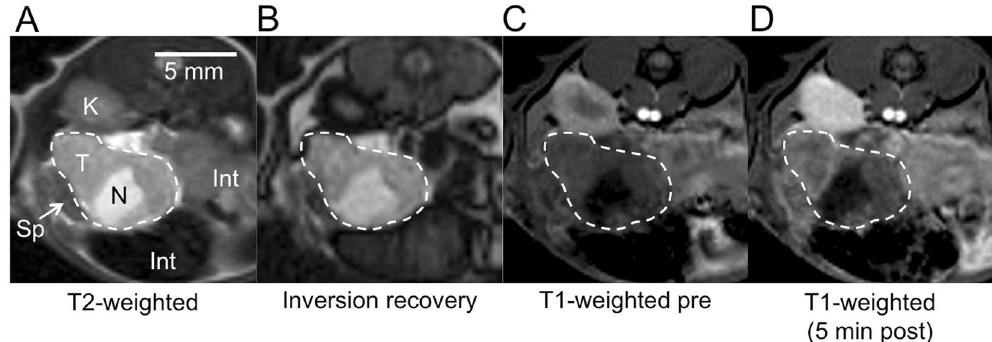
Figure 2. Axial MR images used to identify and characterize PDAC tumours in the mouse abdomen. Tumour is outlined. (A ) T2-weighted image. T = tumour, N = necrosis, Sp = spleen, K = kidney, Int = intestine. ( B ) Pre- injection inversion recovery image (TR/TE/TI = 3200 ms/9.6 ms/487 ms). ( C ) Pre-injection T1-weighted image shows little contrast between tumour and surrounding tissue. ( D ) T1-weighted image at 5 min after injection of the collagen-targeted probe shows improved contrast and heterogeneous signal enhancement within the tumour.